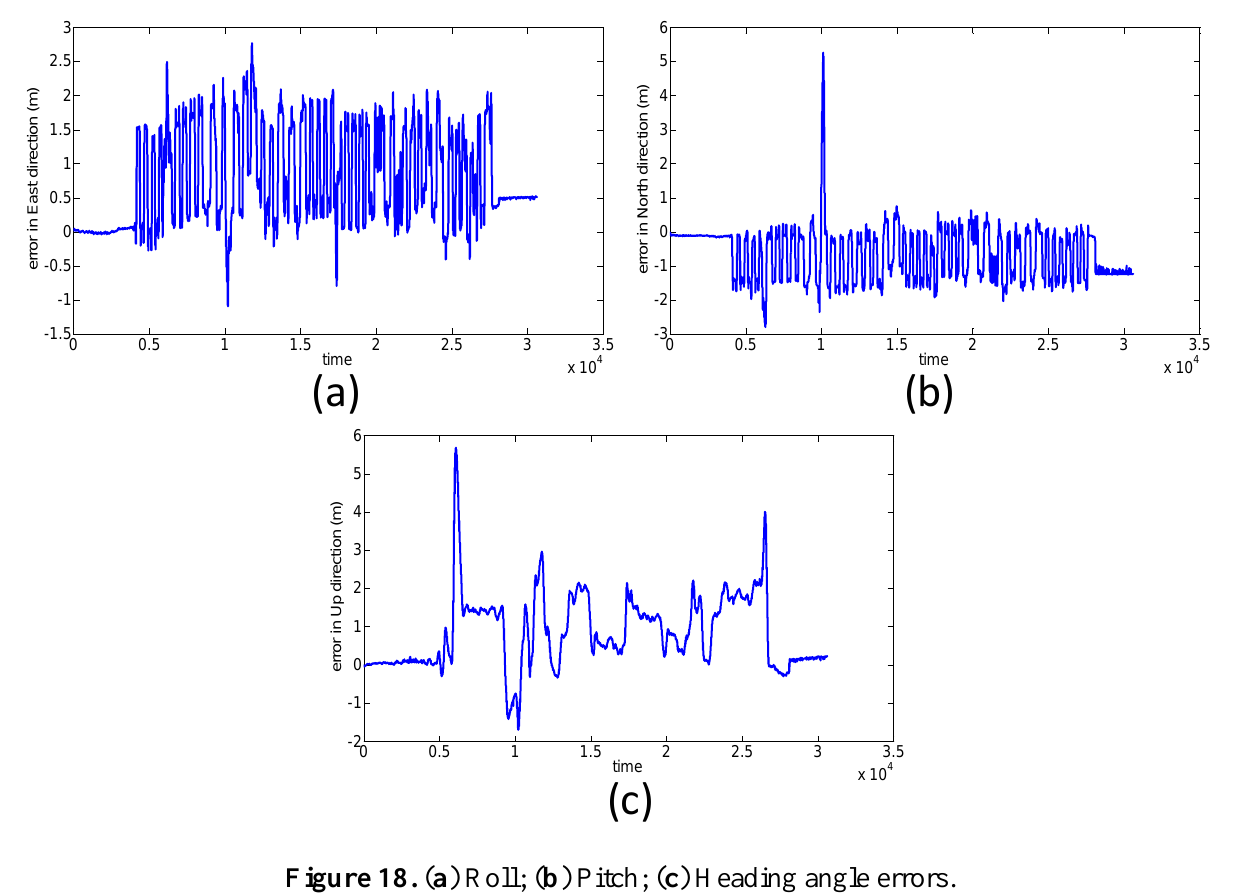
Figure 17. Positional error in ( a ) east; ( b ) north; ( c ) up directions.